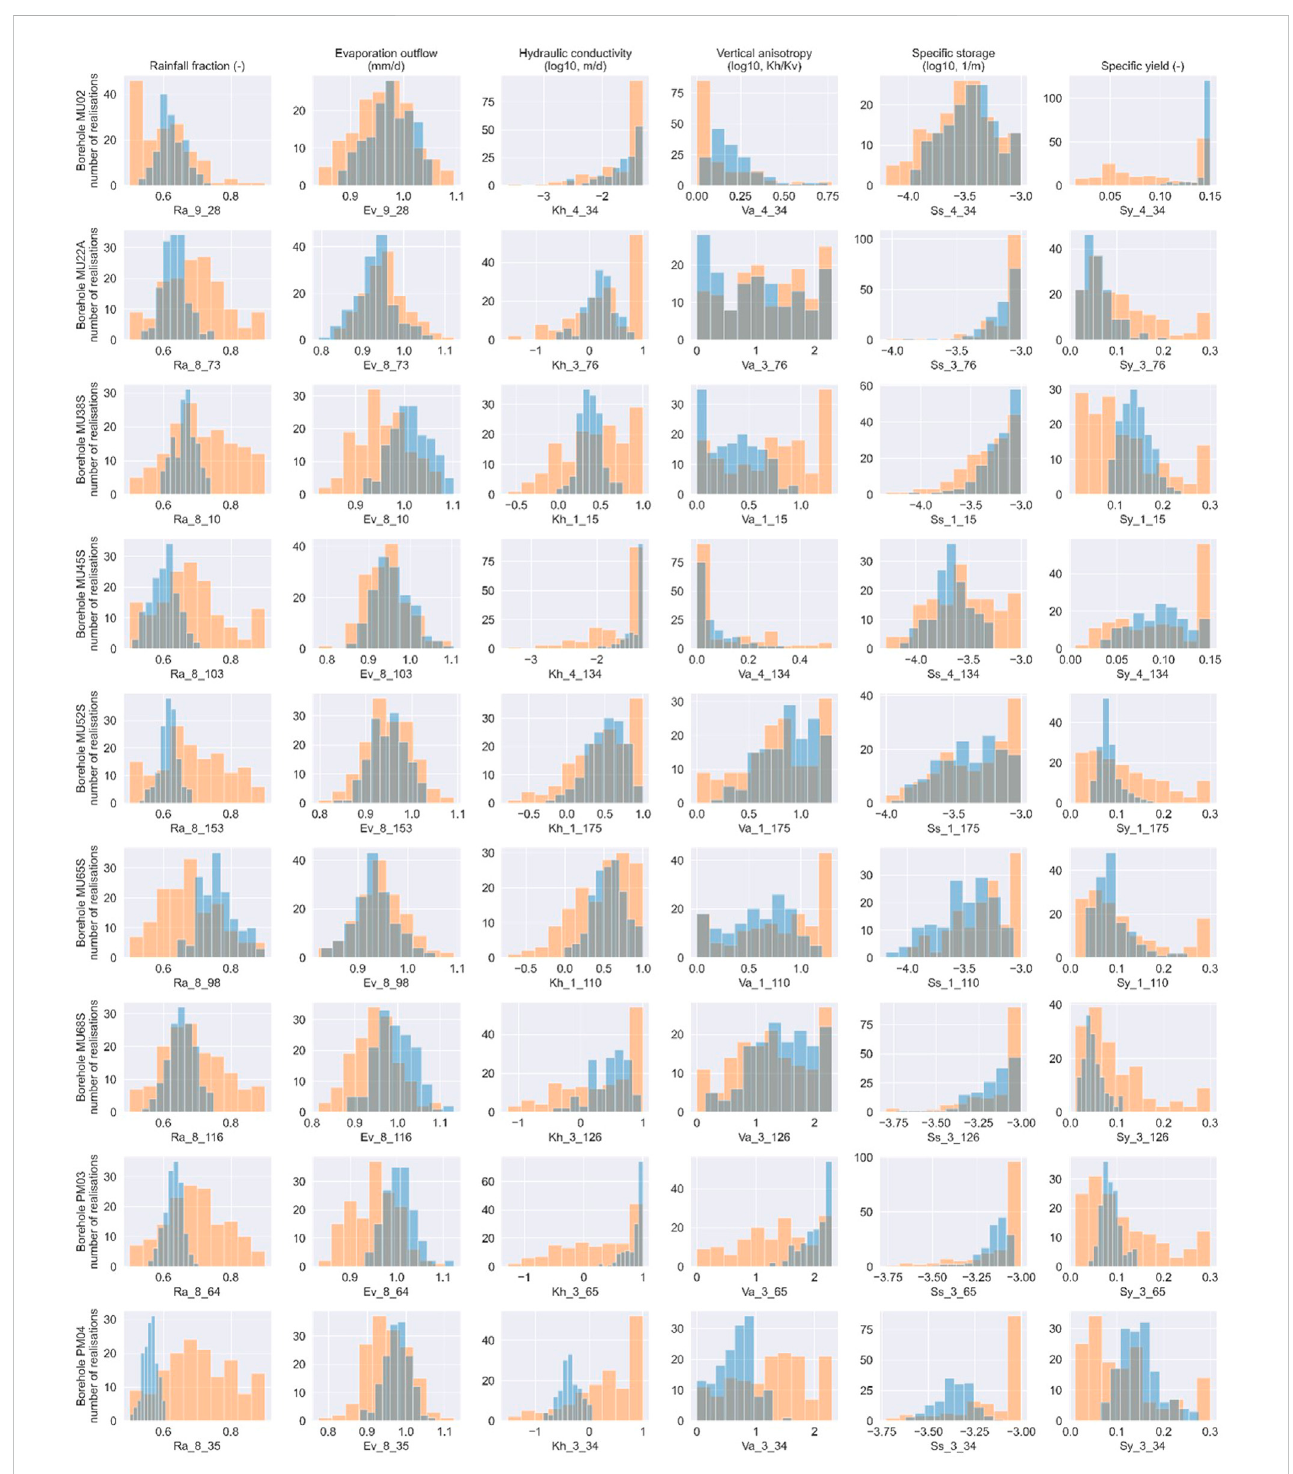
FIGURE 10 Parameter histograms of prior (orange) and posterior (blue) distributions of most sensitive parameters to observationsin selected monitoring boreholes.